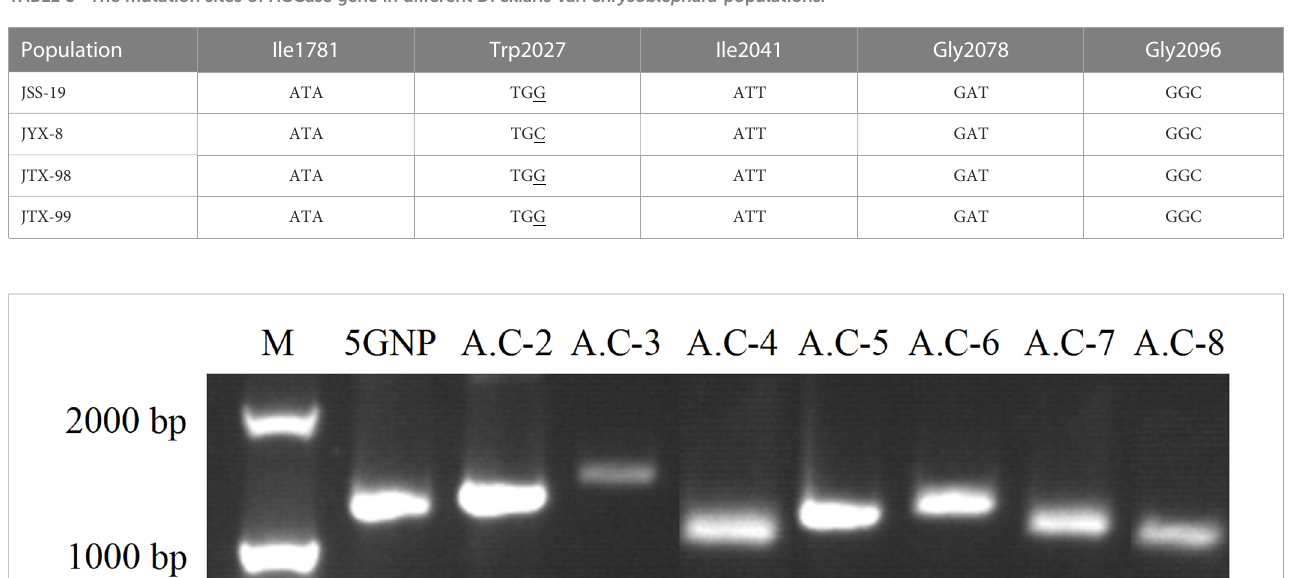
(Figure 2). The complete ACCase cDNA fragment was 7,277 bp in length and the ORF length was 6,966 bp. BLASTx analysis of the complete sequence against the NCBI database (Table 6) indicated the presence of amino acid sequence homology of 95.17%, 95.04%, 95%, and 94.10% between the ACCase encoded by the gramineae weeds Panicum hallii , Setaria viridis , Setaria italica , and Echinochloa crus- galli , respectively, suggesting that the ampli fi ed sequence was indeed an ACCase gene.